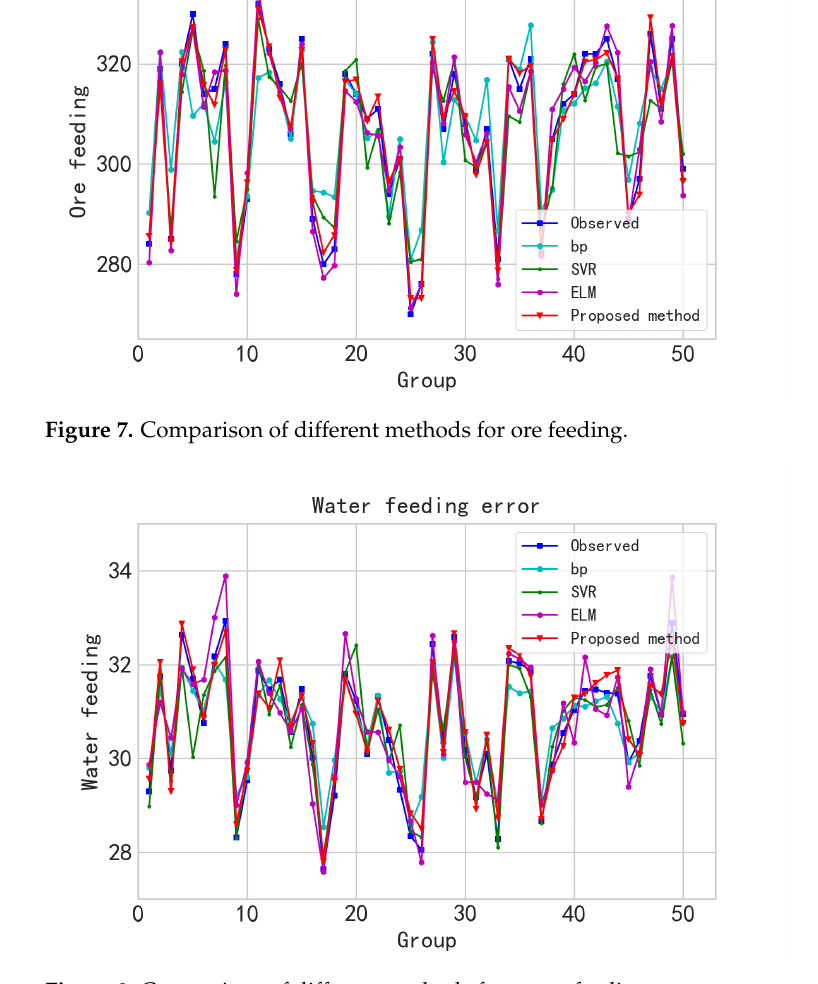
Figure 8. Comparison of different methods for water feeding. The MAE, MAPE, and RMSE of each algorithm are shown in Table 4. Table 4. Comparison of setting